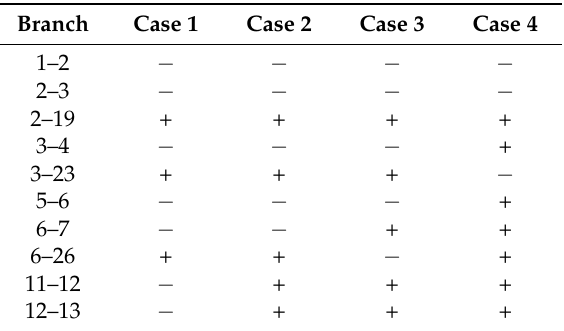
Table 2. Results of upstream or downstream relationship judgment.